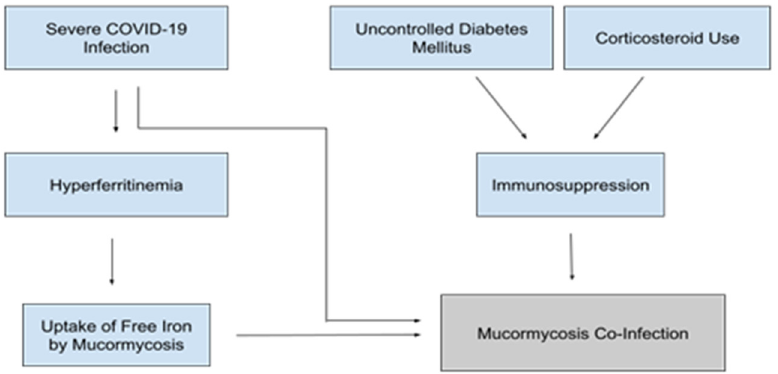
Figure 4. Factors contributing to the pathogenesis of Mucormycosis coinfections in patients with severe COVID-19